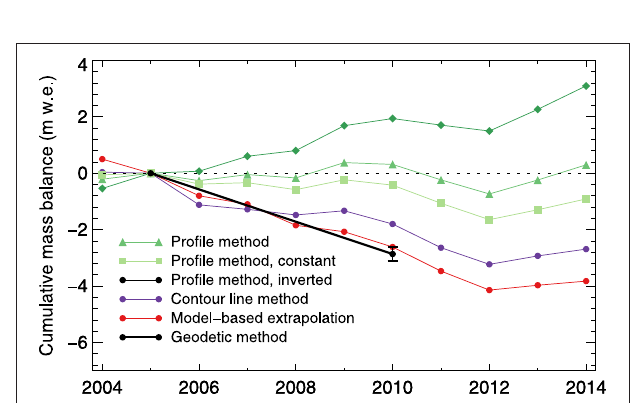
FIGURE 4 | Cumulative mass balance of Findelengletscher 2004–2014 obtained from the profile method (green), with a linear gradient for the entire glacier surface, constant accumulation above 3460ma.s.l., and an inverted elevational trend above the same elevation; (violet) the contour method ; (red) the model-based extrapolation scheme; (black) the geodetic mass change that is given as reference. Note that the geodetic mass change covers the period 2005–2010 and, for visualization, balance series were aligned by the 2005 data points. Results from the inverse distance weighted interpolation (IDW) of observations are not shown because they are outside the plot range ( 12.2mw.e. for 2005–2014). −